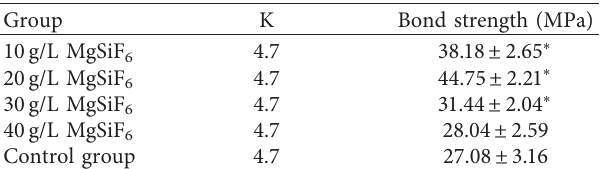
Table 3: Bonding strength of different titanium-porcelain resto- rations (mean ± SD, n �